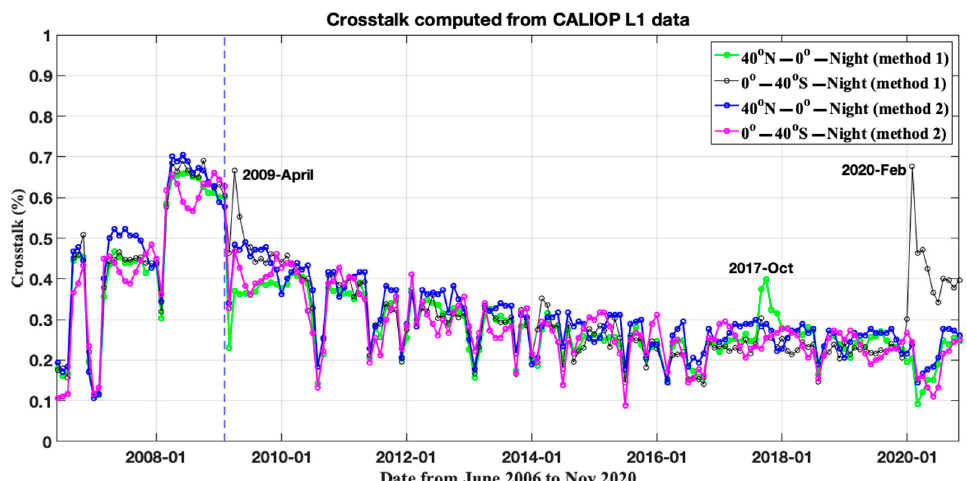
Figure 1. Time series of crosstalk calculated from CALIOP L1 data by methods 1 and 2 from June 2006. to November 2020 over two chosen regions 0°–40° N (green by method 1 and blue by method 2) and 0°–40° S (black by method 1 and pink by method 2). The dashed blue line indicates when CALIOP was switched from the primary laser to the backup laser (i.e., February 2009). The discrete jumps in April 2009, September/October 2017, and February 2020 by method 1 are most likely due to the depolarizing smoke injected into the stratosphere. See details in text.